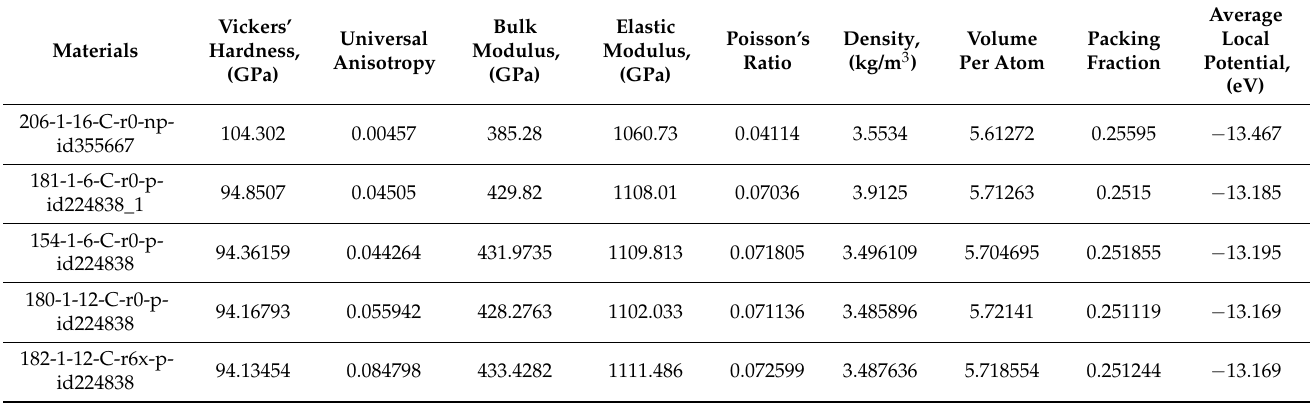
Table 2. Carbon allotropes with high Vickers’ hardness with other material properties.